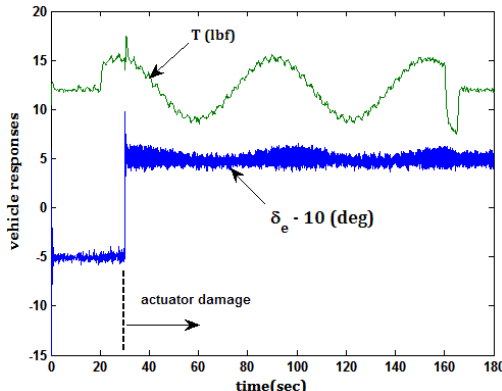
Figure 12. Elevator and thrust inputs for Task